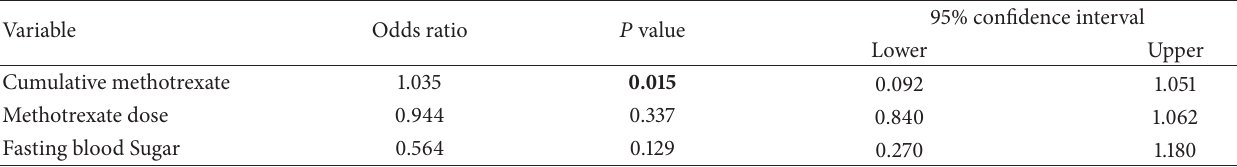
Table 2: Multivariate analysis of independent prediction of NAFLD with